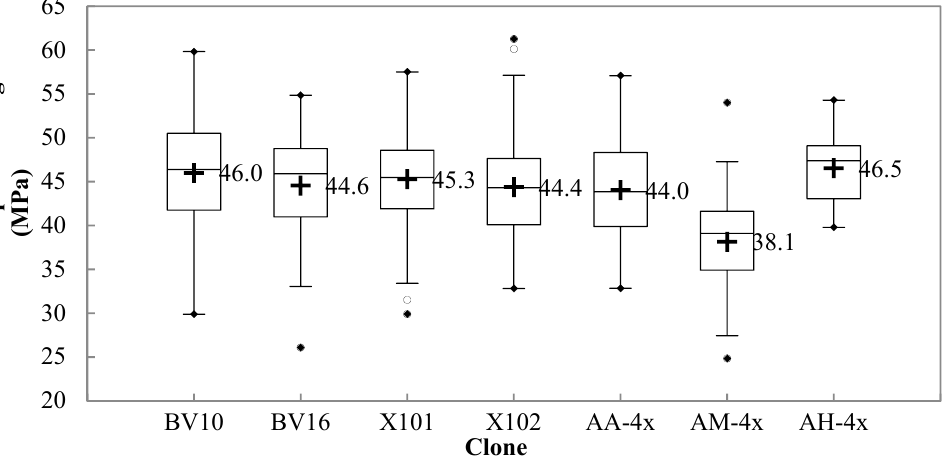
Figure 11. Variation of ultimate stress in compression parallel to the grain (MPa).